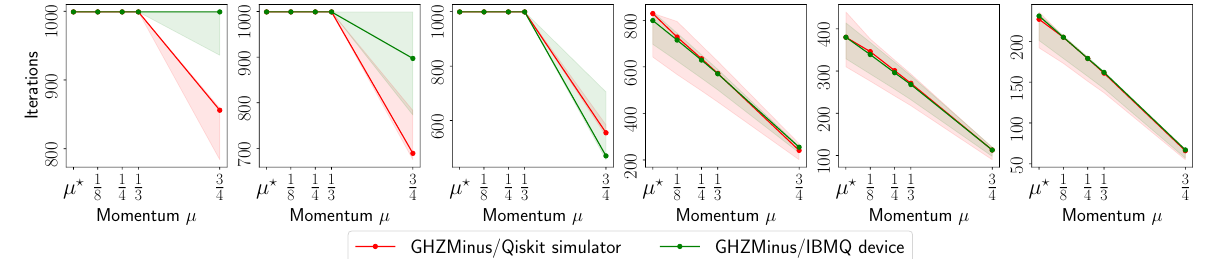
( 6 ) circuit using using real measure- −